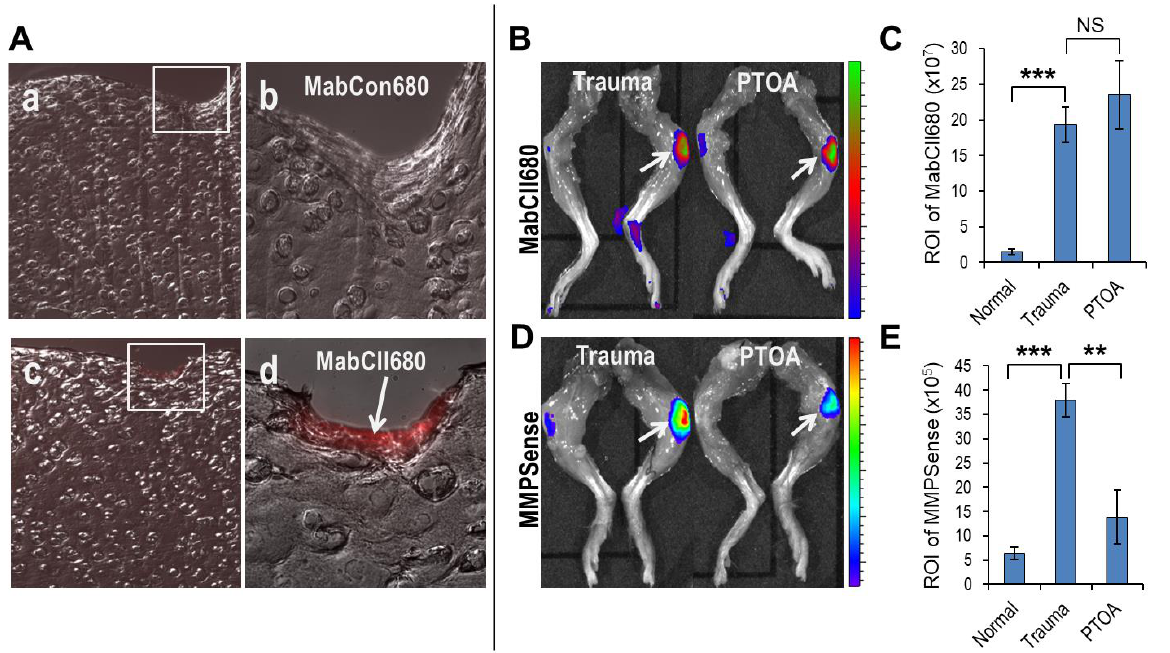
Figure 2. Assessment of cartilage damage and MMPs level in Trauma and PTOA groups. ( A ) Frozen sections showing specificity of MabCII680 to the exposed type-II collagen in the physically damaged cartilage tissue at low ( c ) and high ( d ) magnification as compared to control MabCon680 at low ( a ) and high ( b ) magnification. ( B , C ) IVIS image and graphical representation of cartilage damage in Trauma and PTOA knee joints. ( D , E ) IVIS image and graphical representation of MMPs level in Trauma and PTOA knee joints. Data are represented as mean ± SD. NS: not significant, ** p < 0.01 and *** p < 0.001. ( n = 6 per group).